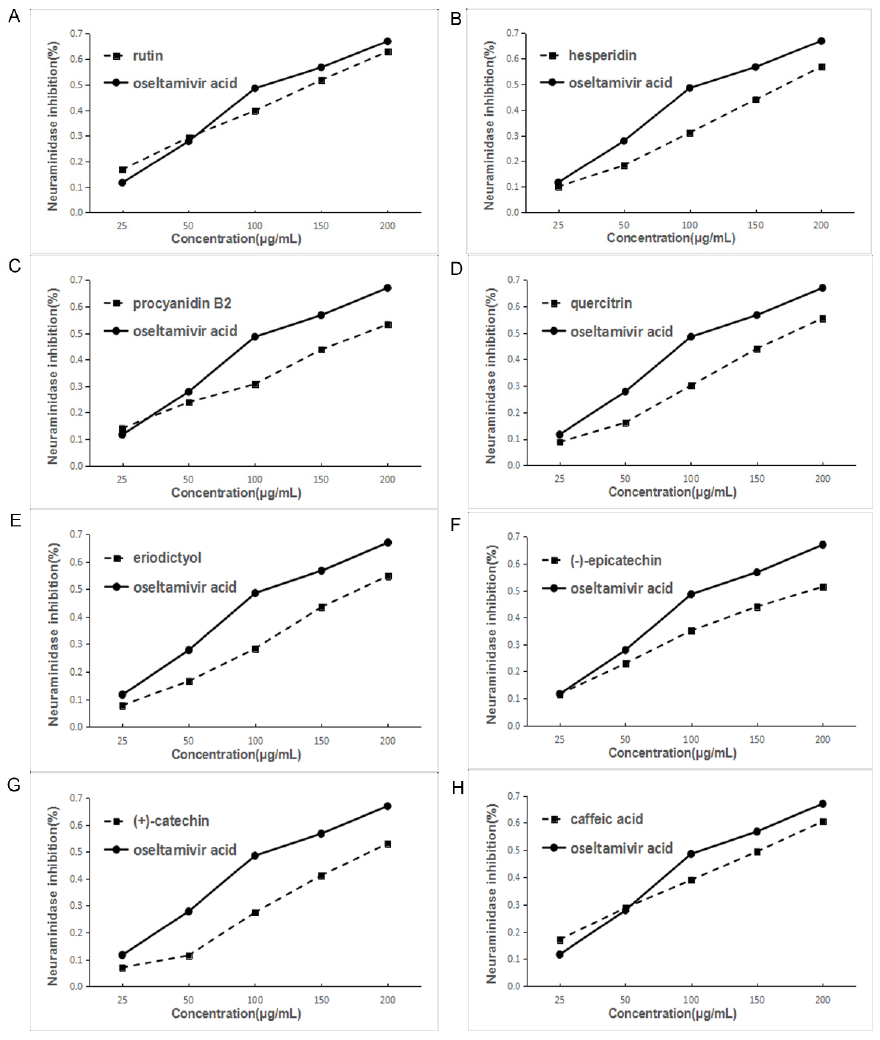
Figure 6. Inhibition of NA activity by various components of EA extract of F. dibotrys. (( A ), rutin; ( B ), hesperidin; ( C ), procyanidin B 2 ; ( D ), quercitrin; ( E ), eriodictyol; ( F ), ( − )-epicatechin; ( G ), (+)-catechin; ( H ), caffeic acid). Table 2. The IC 50 values of 8 main chemical compounds in F. dibotrys on neuraminidase (NA) inhibition assay.